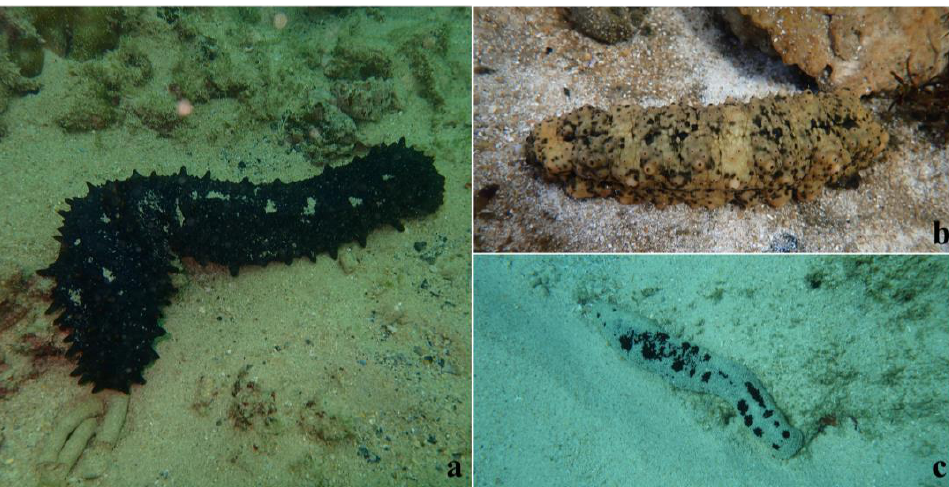
Figure 1. Samples and surrounding environment taken in the process of sample collection from Wuzhizhou island: ( a ) S. chloronotus ; ( b ) S. monotuberculatus ; ( c ) H. atra